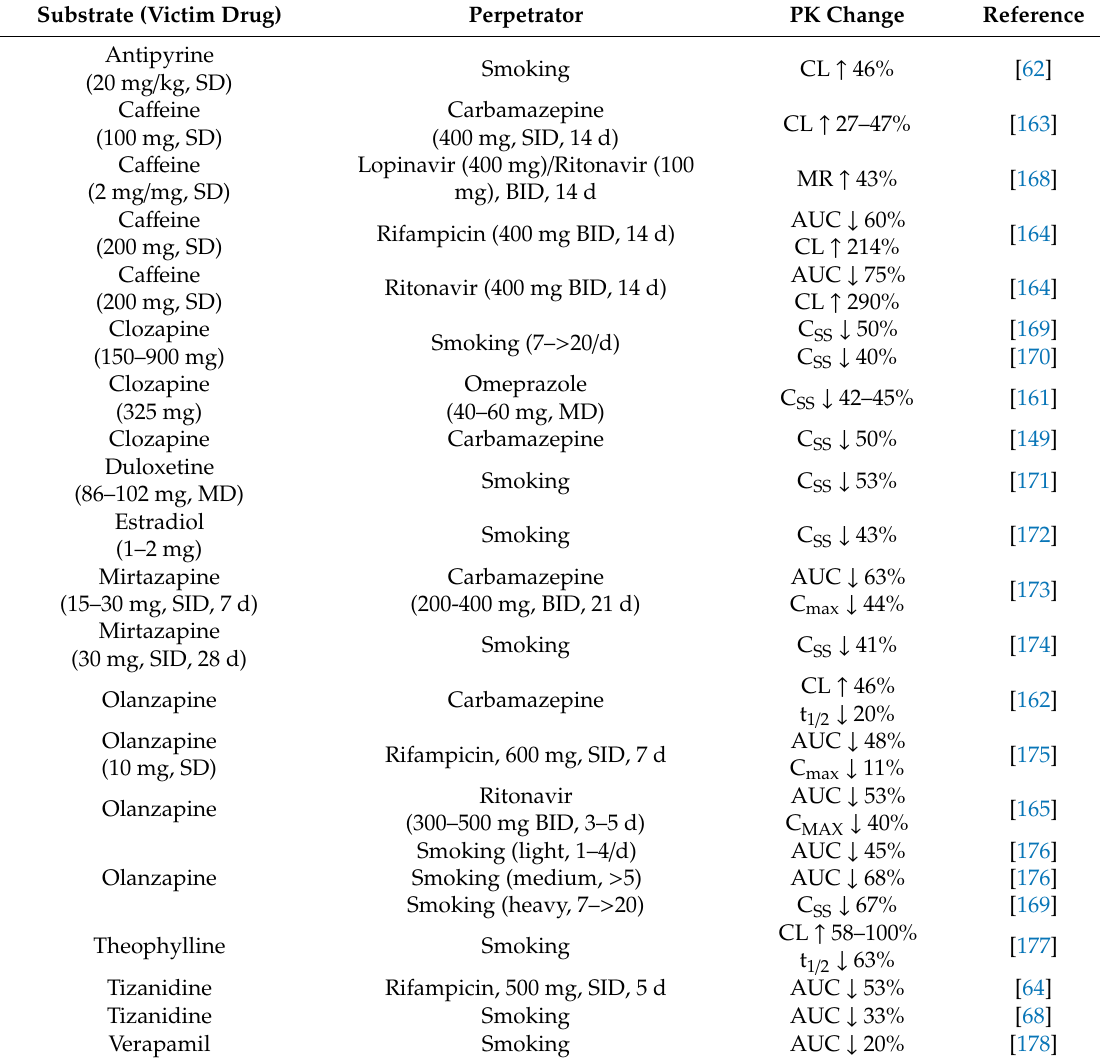
Table 6. Overview of clinically relevant interaction as caused by induction of CYP1A1 / 1A2